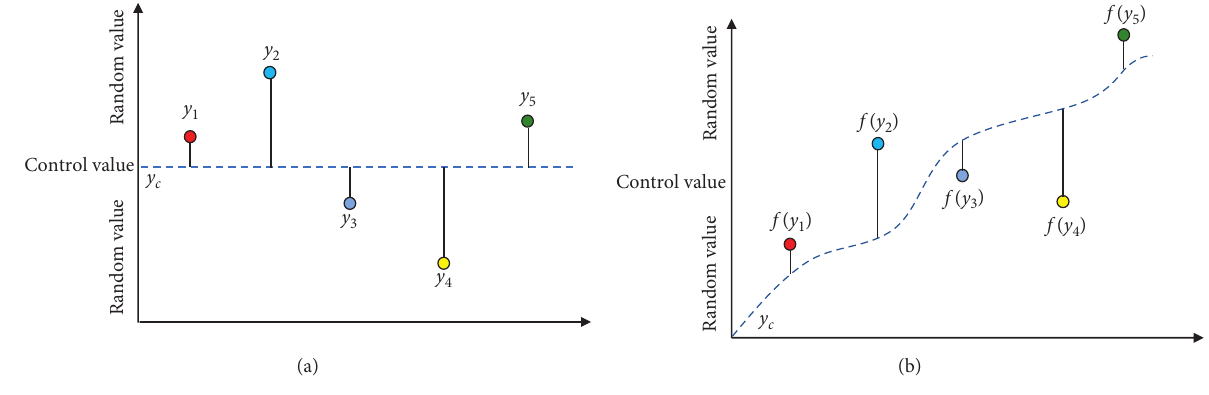
Figure 3: The schematic diagram of the least square